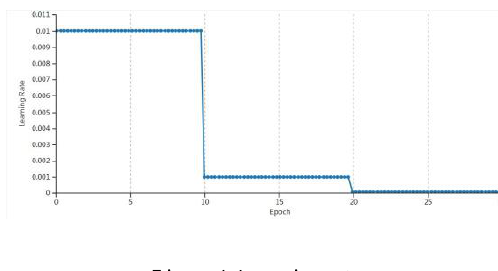
Figure 4. Learning rate